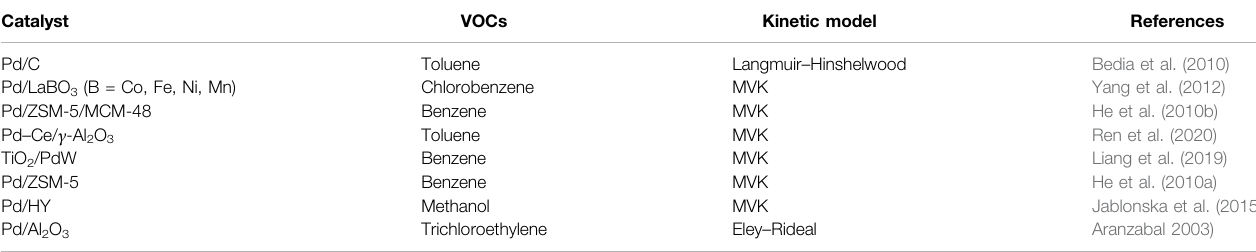
TABLE 4 | Catalytic oxidation of representative VOCs with different kinetic models.